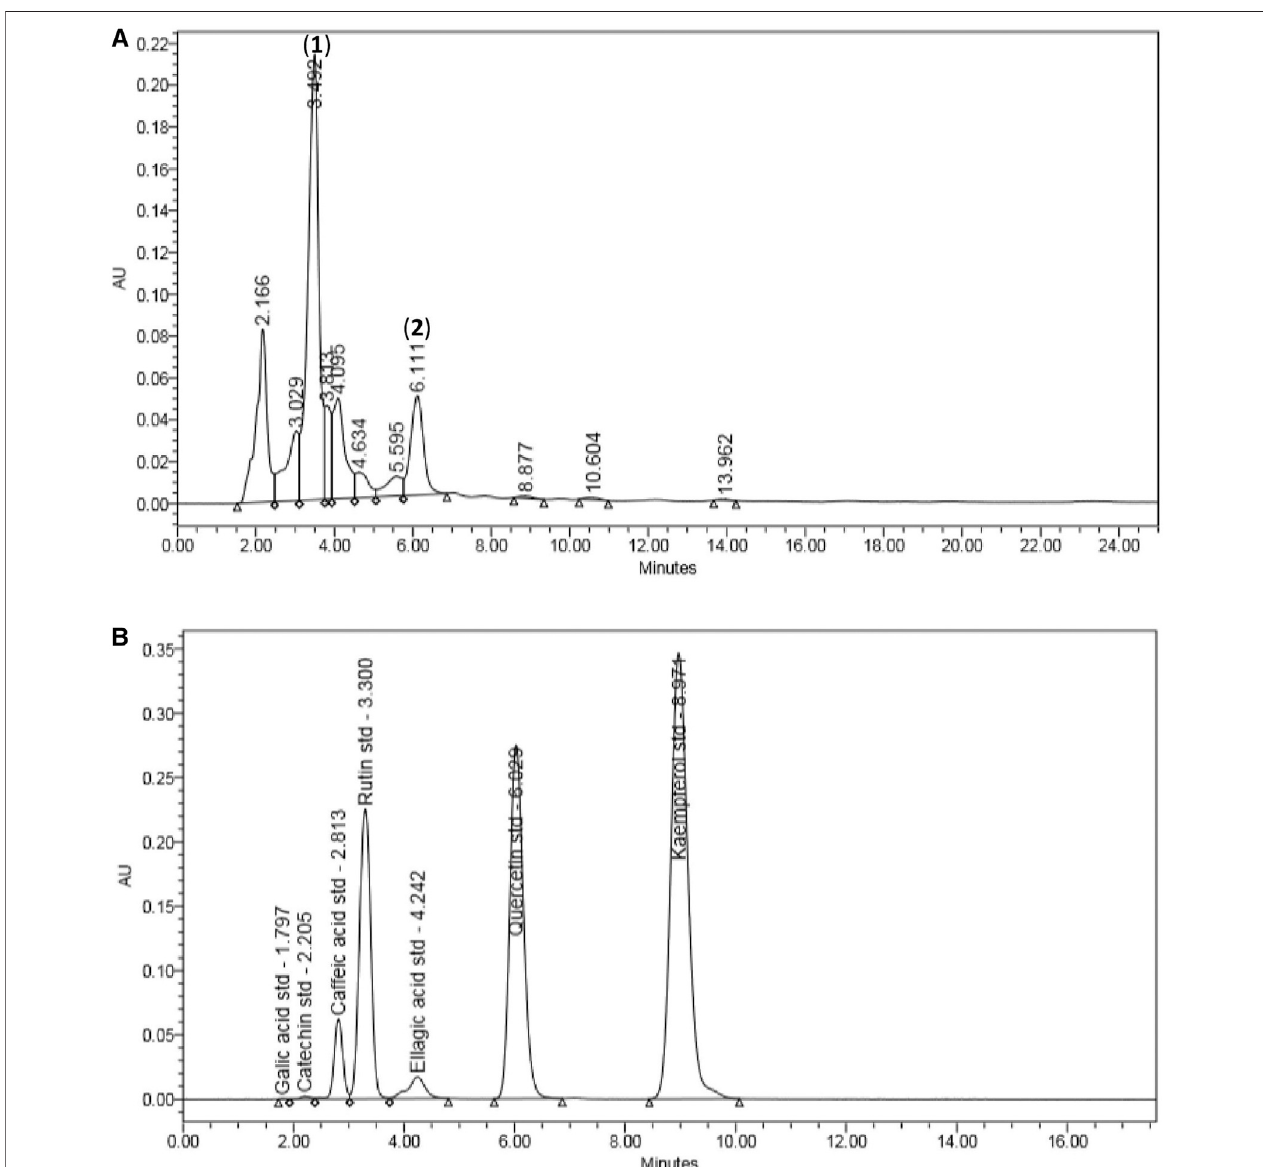
FIGURE 2 | Chromatographic analysis of (A) Parkia speciosa empty pod crude extract with detected rutin ( 1 ) and quercetin ( 2 ), and (B) the standard known compounds.